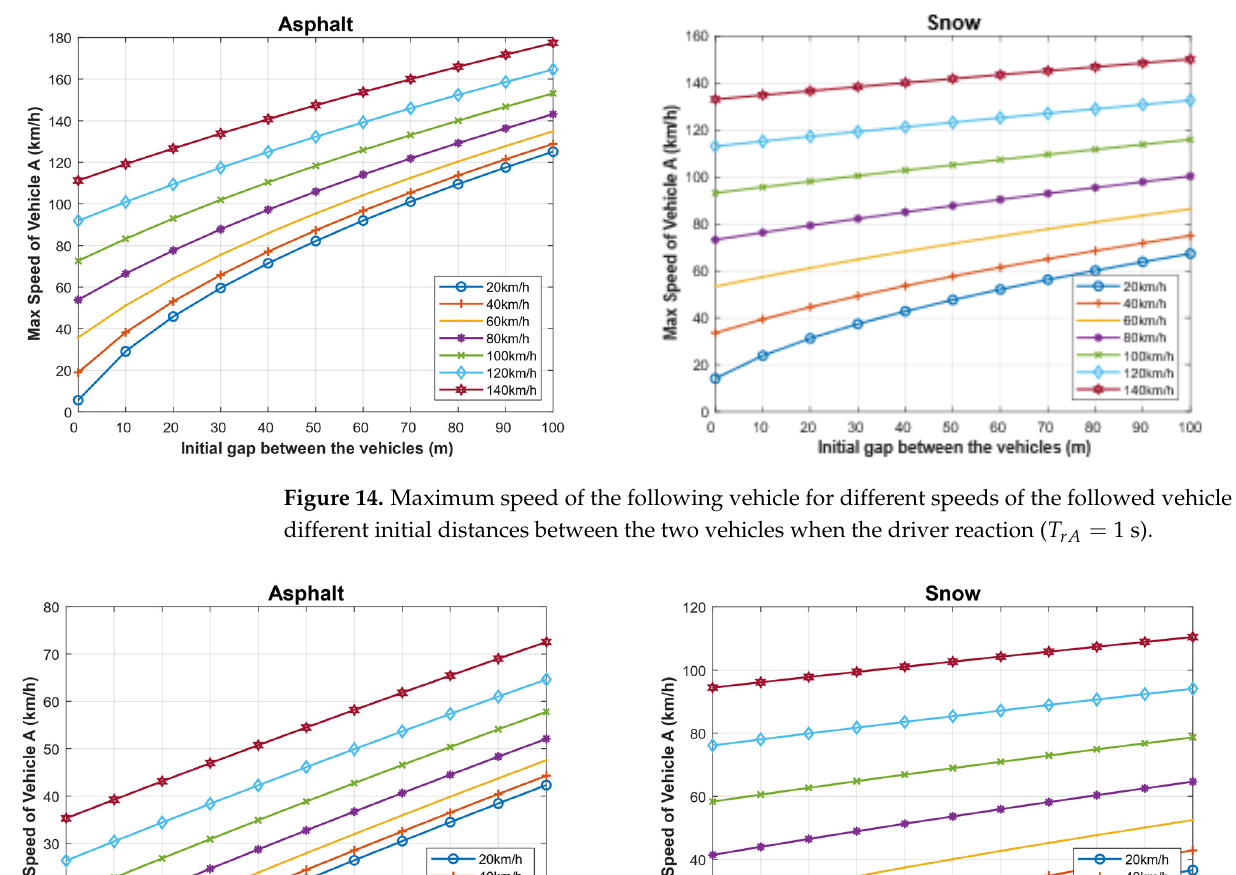
Figure 16. Minimum safe driving distance for different speeds of both the following and the fol- lowed vehicle in the case when the weather is clear, assuming the driver reaction time is 1 s for dry asphalt and snowy roads.